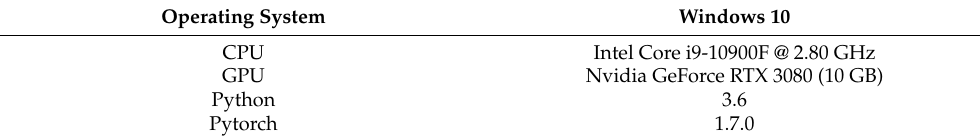
Table 2. The configuration of the experimental environment.